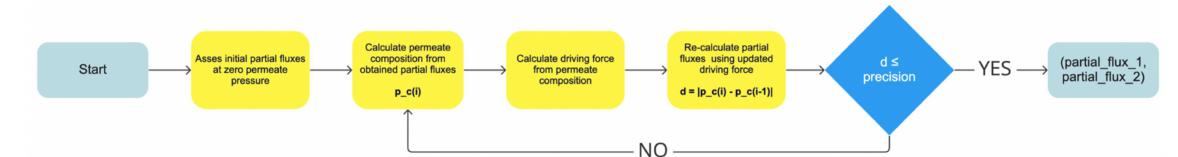
Figure 4. Schematic representation of the partial flux calculation